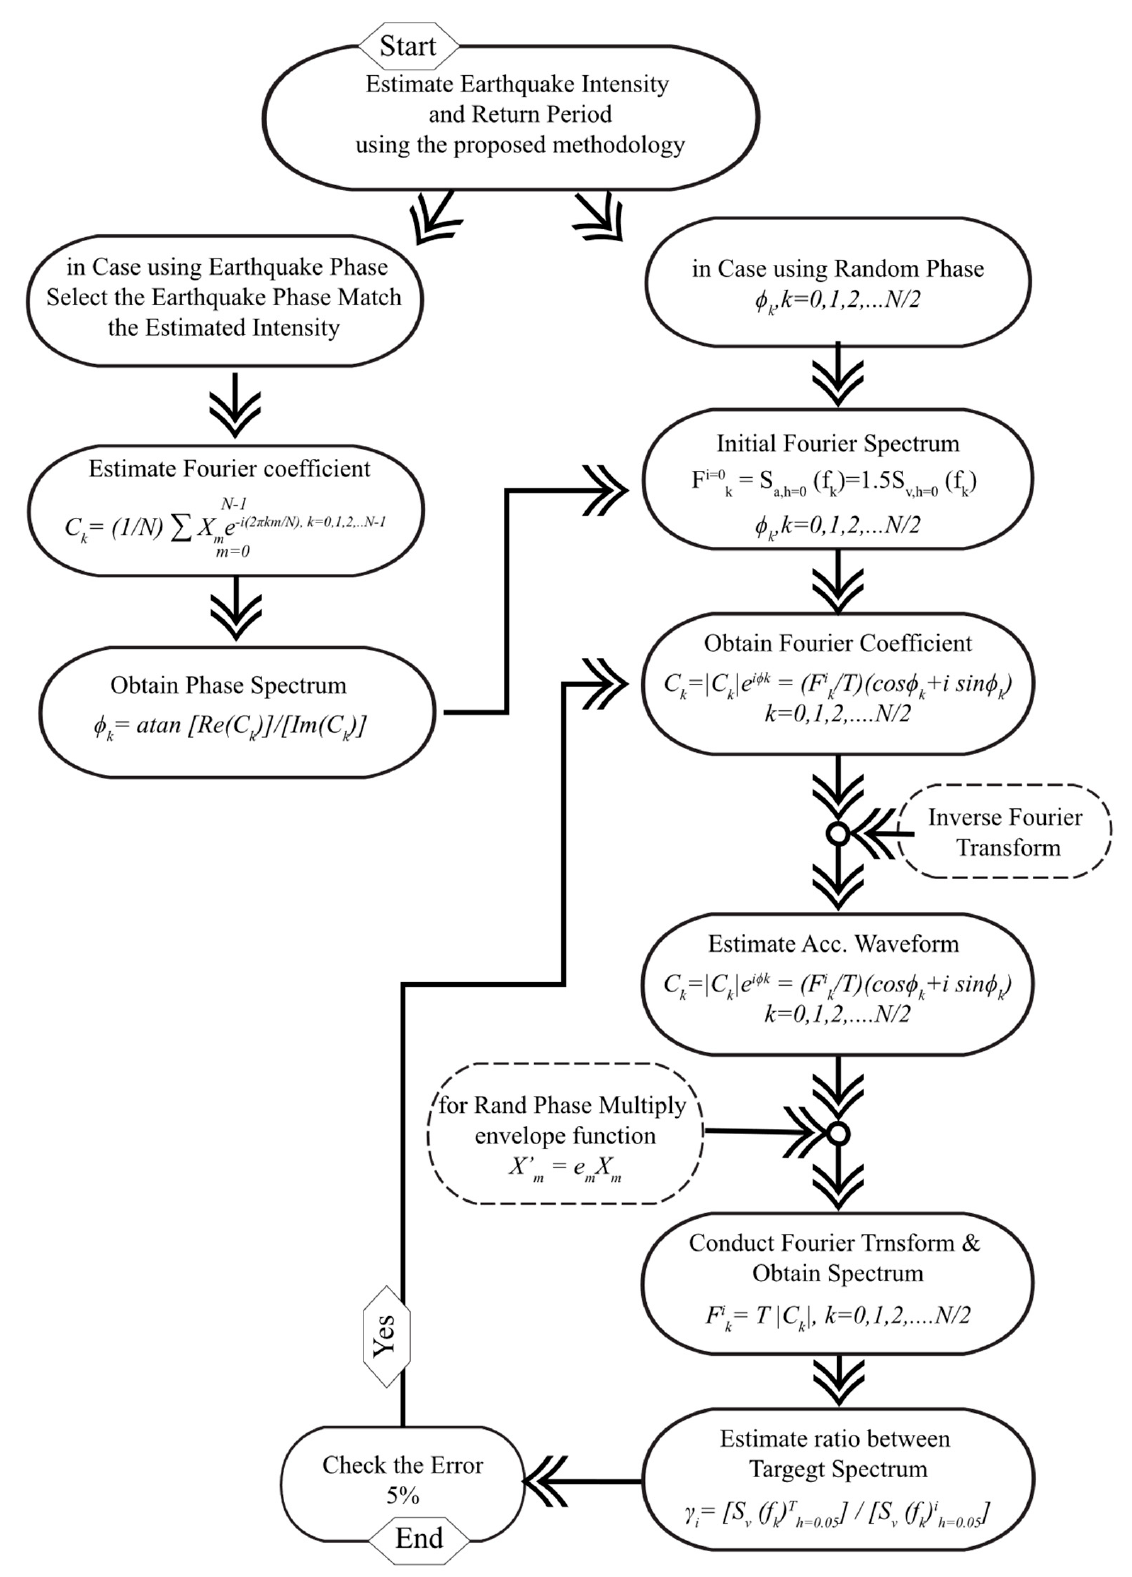
Figure 11. Flowchart of the STERA_Wave algorithm to generate spectrum-compatible earth- quakes.